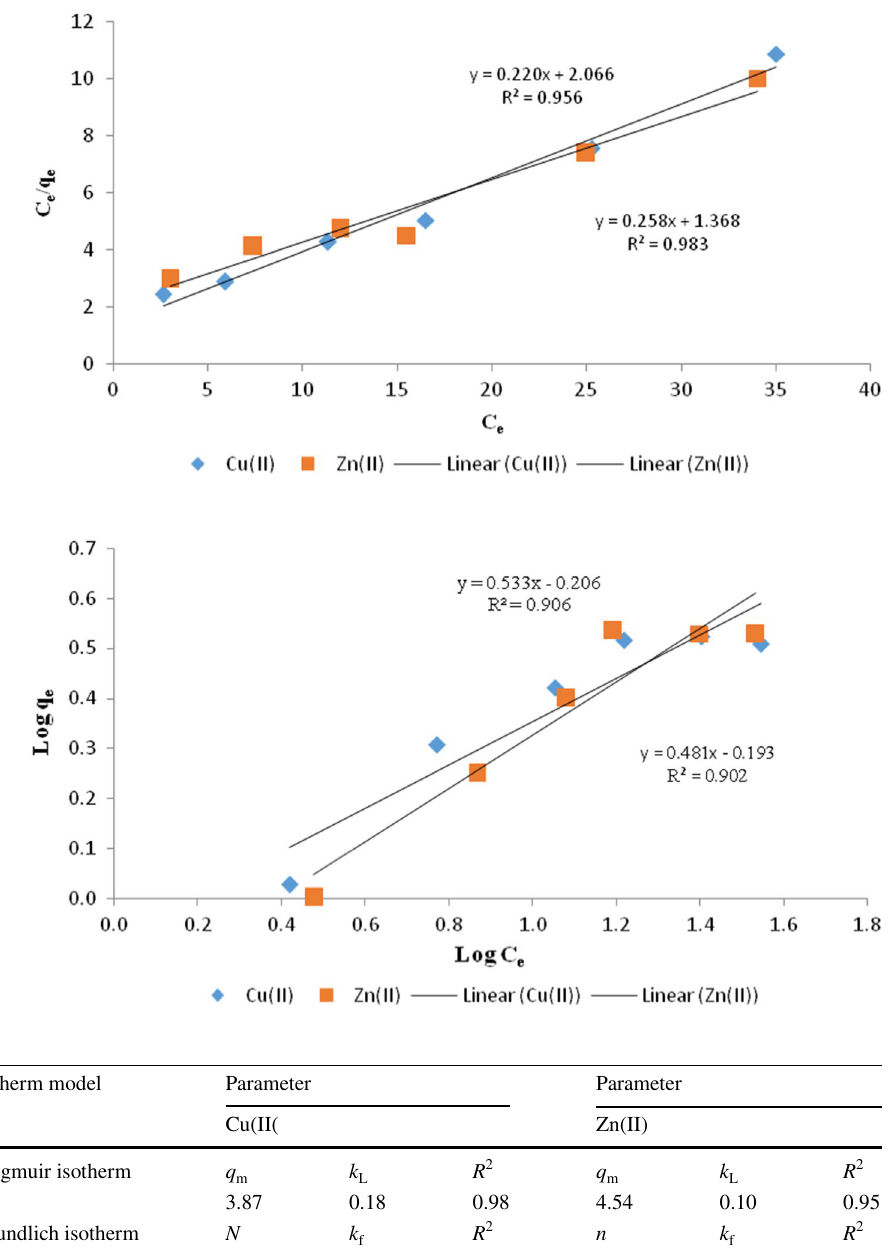
Fig. 3 Langmuir adsorption isotherm model (metal initial concentrations of 10, 20, 30, 40, 50 and 60 mg/L, incubation duration of 10 days, incuba- tion temperature of 28 °C, and shaker rate of 150 rpm)